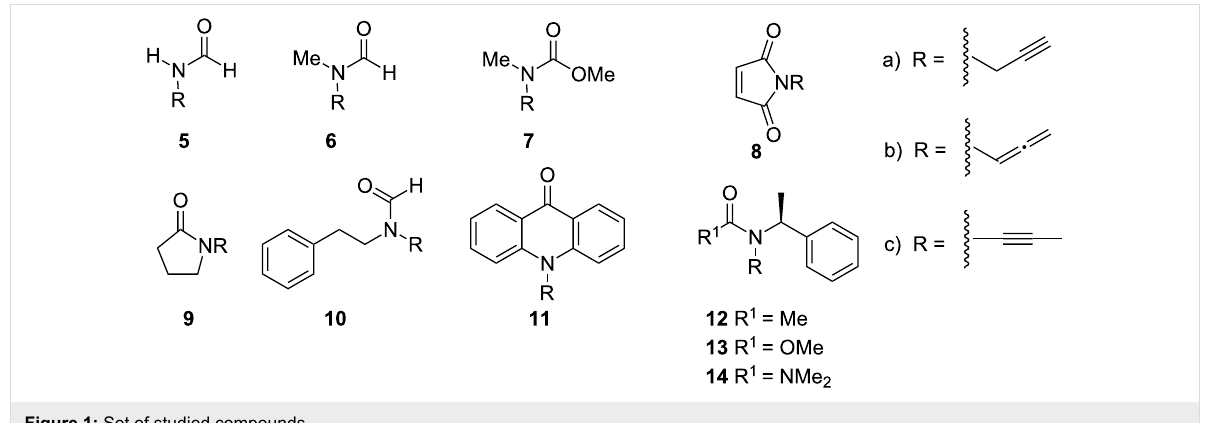
Figure 1: Set of studied